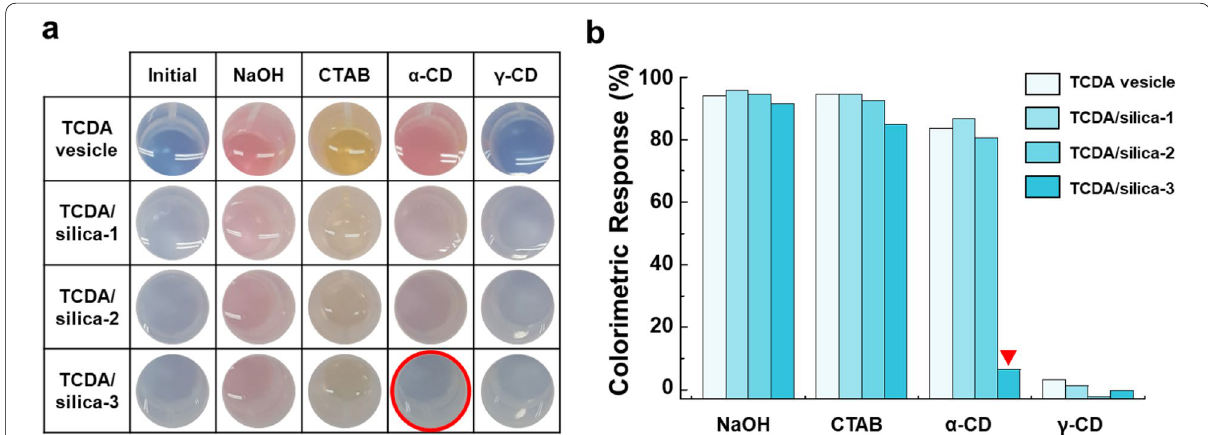
Fig. 6 Size-selective recognition of TCDA vesicles in silica armor membranes. a Photo-images and b colorimetric response values of TCDA vesicle in silica membrane with 10 mM of chemical stimuli. The CR value of PCDA/silica-3 lowered significantly in response to α-CD (red highlight). The n value of PCDA/silica-n indicates the number of silica armor